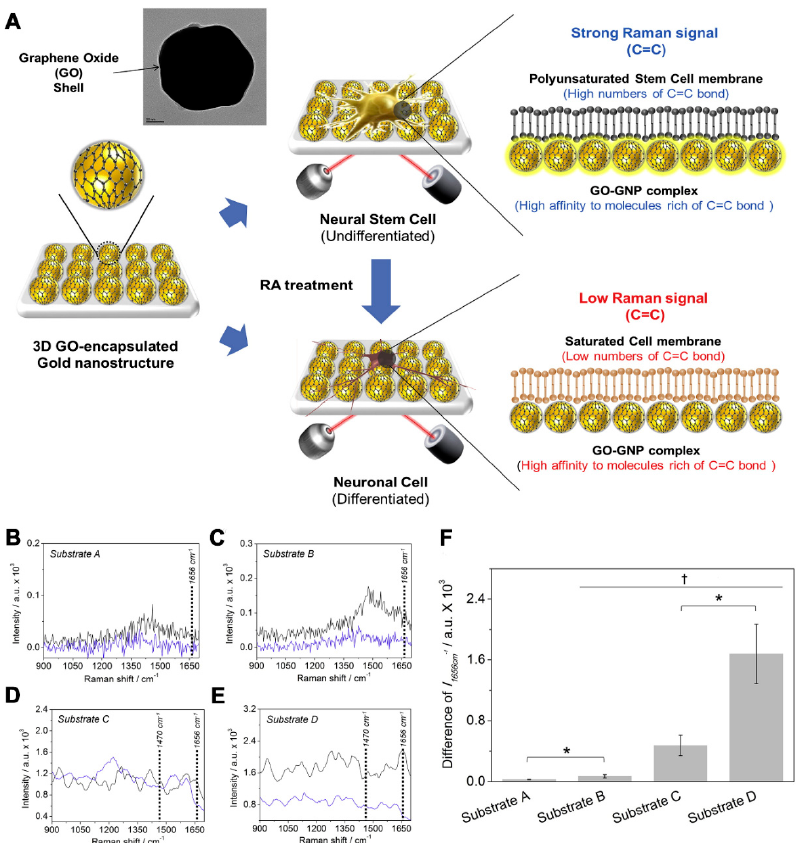
Figure 2. ( A ) Detection strategy to monitor the differentiation of mouse neural stem cells